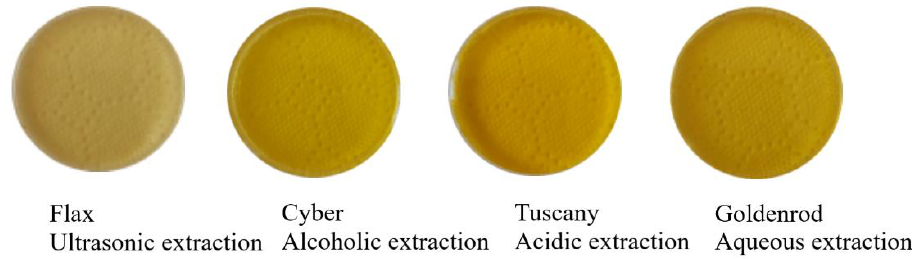
Figure 4. Shades of pure celandine extracts.